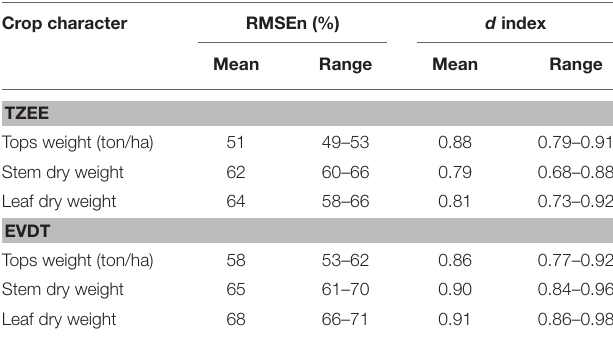
TABLE 5 | Mean and range for normalized root mean square error (RMSEn) and d index for model evaluation with time series data for maize grown during the 2014 and 2015 rainy and dry